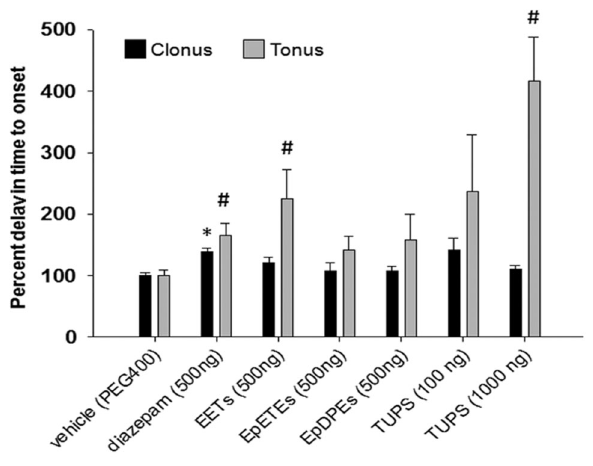
Figure 6. Direct administration of EETs and sEHI into the brain delay onset of PTZ induced seizures. Bar graph of percent change in onset of clonic (black bars) and tonic (gray bars) seizures following intracerebroventricular administration of EpFAs, sEHI and diazepam (n=6–14mice/group). Methyl ester EpFAs, sEHI and diazepam were dissolved in PEG400 and 1 m L was given by i.c.v. route to lightly anesthesized mice in the amounts indicated on x-axis . Thirty minutes after treatments PTZ assay was performed. Among the treatment groups, only diazepam was effective in delaying the onset of clonic seizures (Kruskal-Wallis One Way ANOVA on Ranks followed by Dunn’s multiple comparison, *p # 0.05). Diazepam, EET-methyl esters and high dose of sEHI and were effective in delaying the onset of tonic seizures (Kruskal-Wallis One Way ANOVA on Ranks followed by Dunn’s multiple comparison, **p # 0.05).